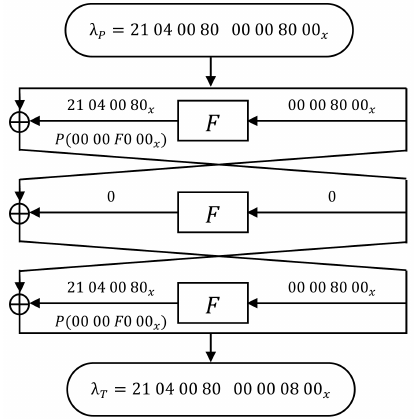
Figure 19: The Best Three-Round Linear Approximation ( λ 9 )